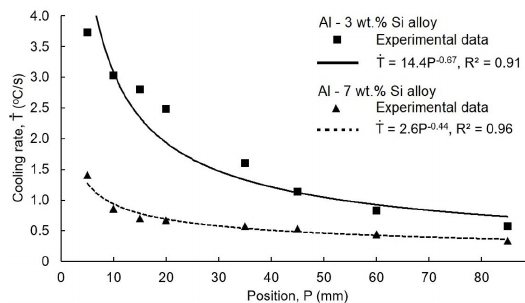
) versus position ( P ). S